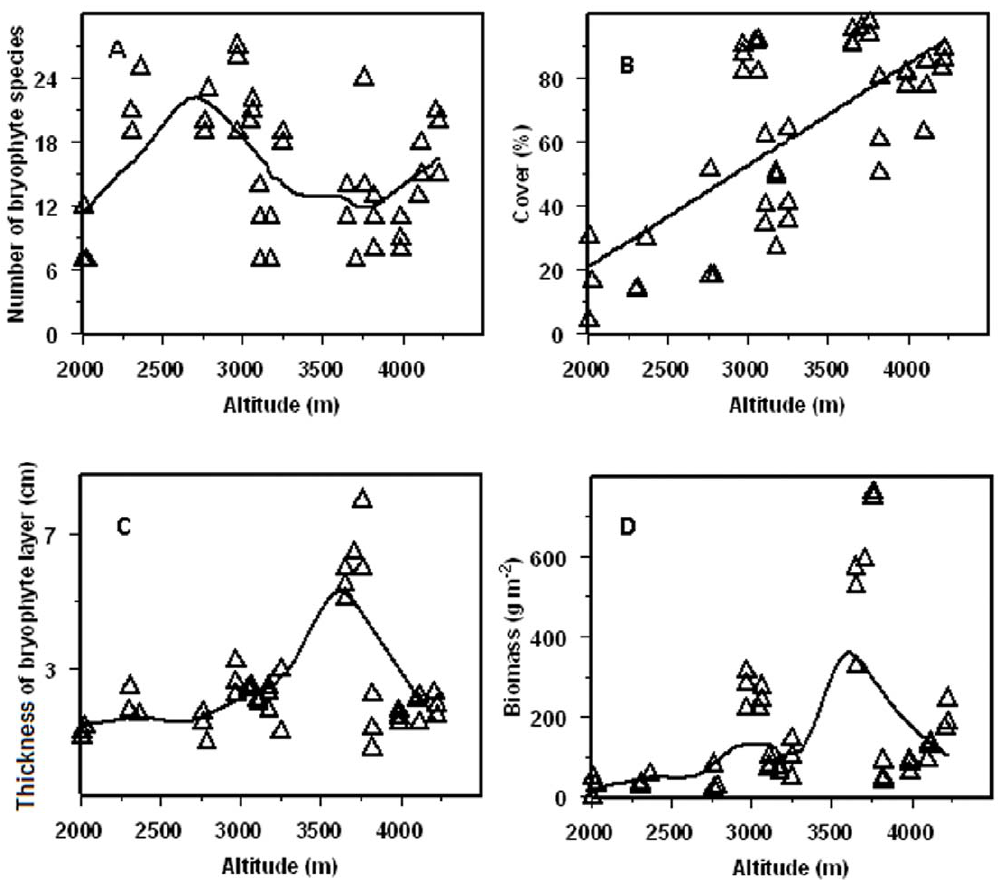
Figure 2. Distribution characters of terrestrial bryophyte along the altitudinal gradient. A, Number of bryophyte species; B, Cover of terrestrial bryophyte; C, Thickness of bryophyte layer; D, Biomass of terrestrial bryophyte.